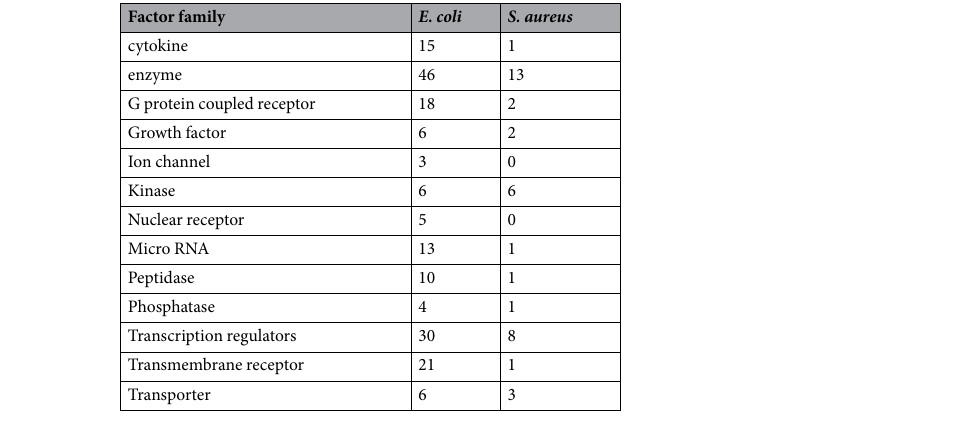
Table 2. Pathogen specific modulation of factor families. Columns indicate the numbers of DEGs contributing to the respective factor family, as identified in E . coli or S . aureus infected